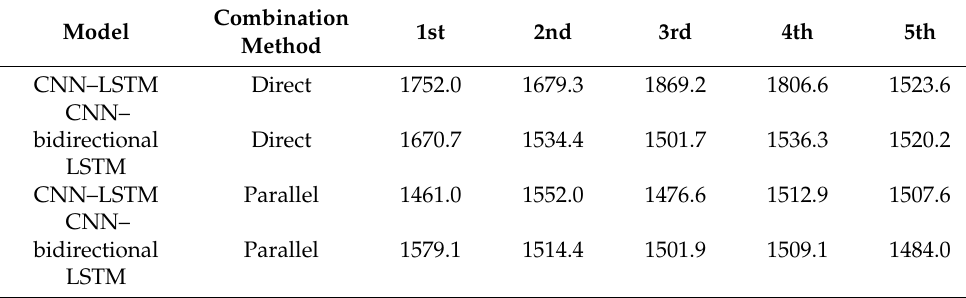
Table 4. RMSE results of each model